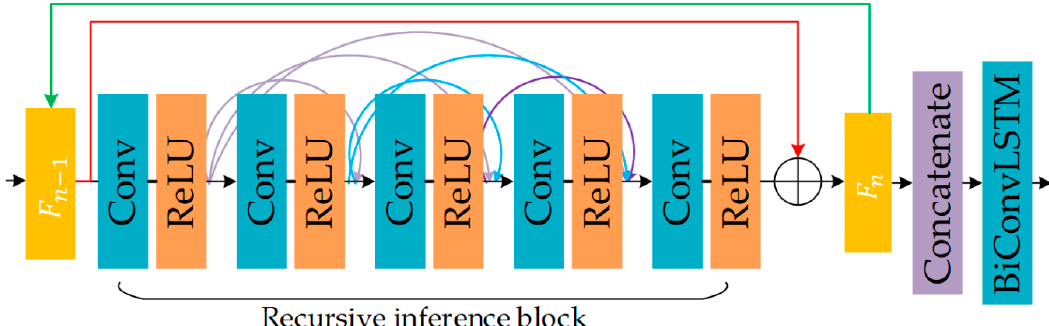
Figure 3. Main contributions of our networks, consisting of two modules: a novel recursive inference block based on the dense connection with shared weights; a BiConvLSTM layer to fuse the concatenation of all recursive inference block outputs to extract complementary information. The green line denotes the recursive learning path by recursively implying the same block and the red line denotes the local residual learning path.